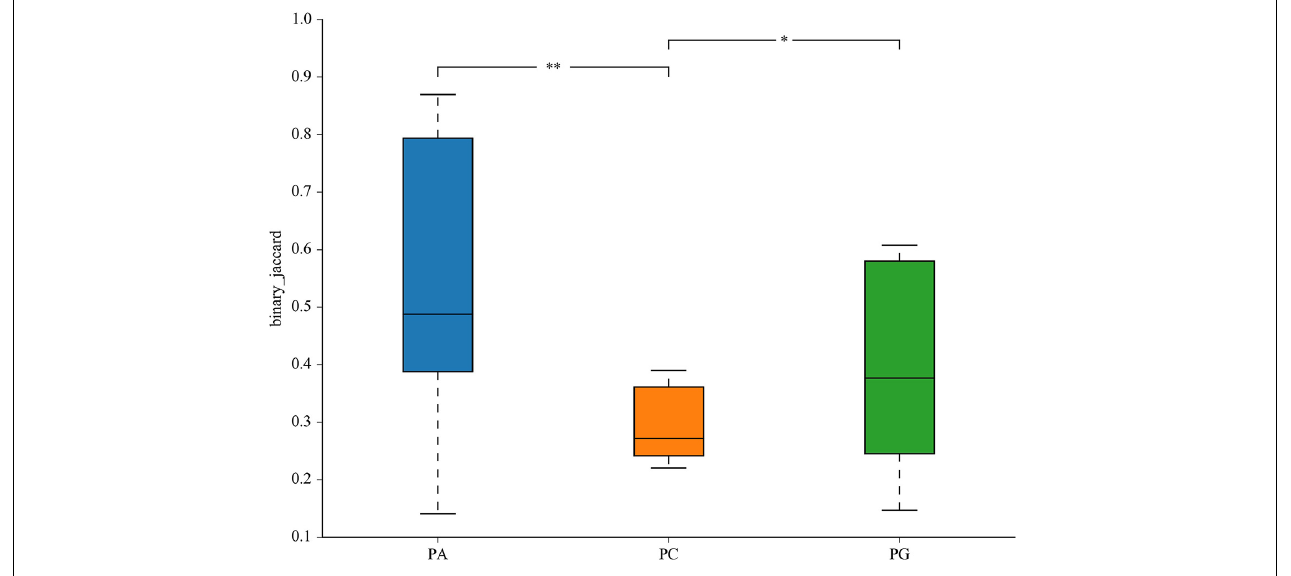
FIGURE 1 | Differential cecum microbiota community ( β diversity) between groups in 25-day-old broilers. PC, basal diet + SNE; PA, basal diet extra antibiotics + SNE; PG, basal diet extra B. licheniformis + SNE. Values are means with their standard errors. * P < 0.05, ** P < 0.01.